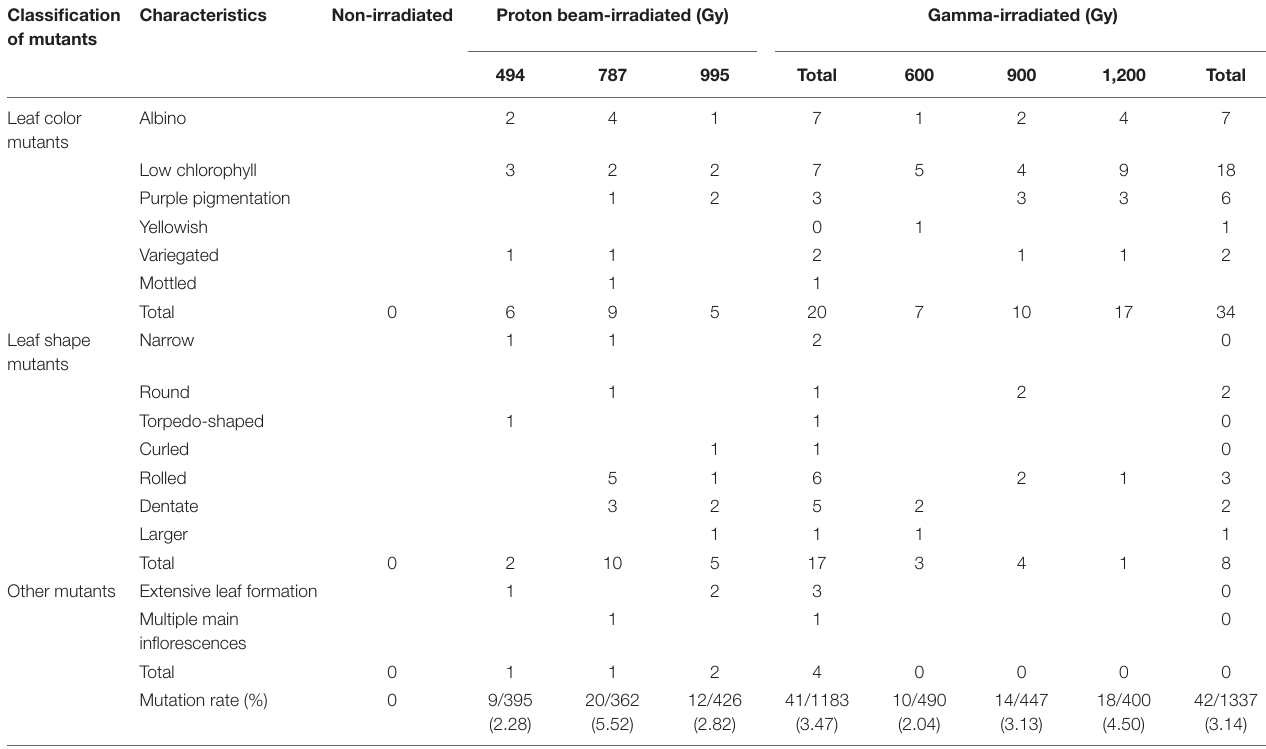
TABLE 1 | Mutant phenotypes in M 2 populations of Arabidopsis irradiated with proton beams or gamma-rays. Classification of mutants